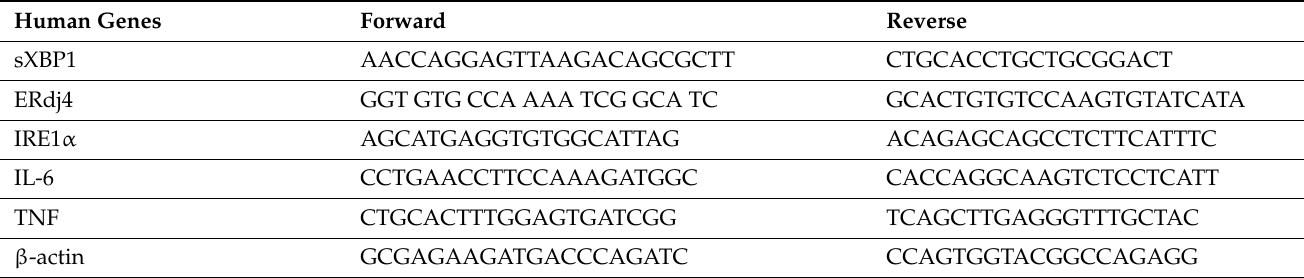
Table 1. List of human primer sequences for